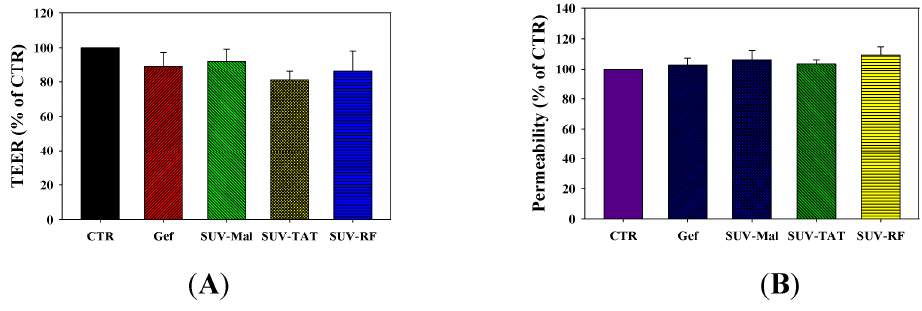
Figure 6. Effect of SUV-RF on the barrier integrity of the BBB model: ( A ) transendothelial electrical resistance after 48-h treatment of free gefitinib, SUV-Mal, SUV-RF, and SUV-TAT on bEnd.3 cells; and ( B ) permeability of sodium fluorescein (SF) across bEnd.3 cells after 48-h treatment of free gefitinib, SUV-Mal, SUV-RF, and SUV-TAT. Values are the mean ± SEM ( n = 4).